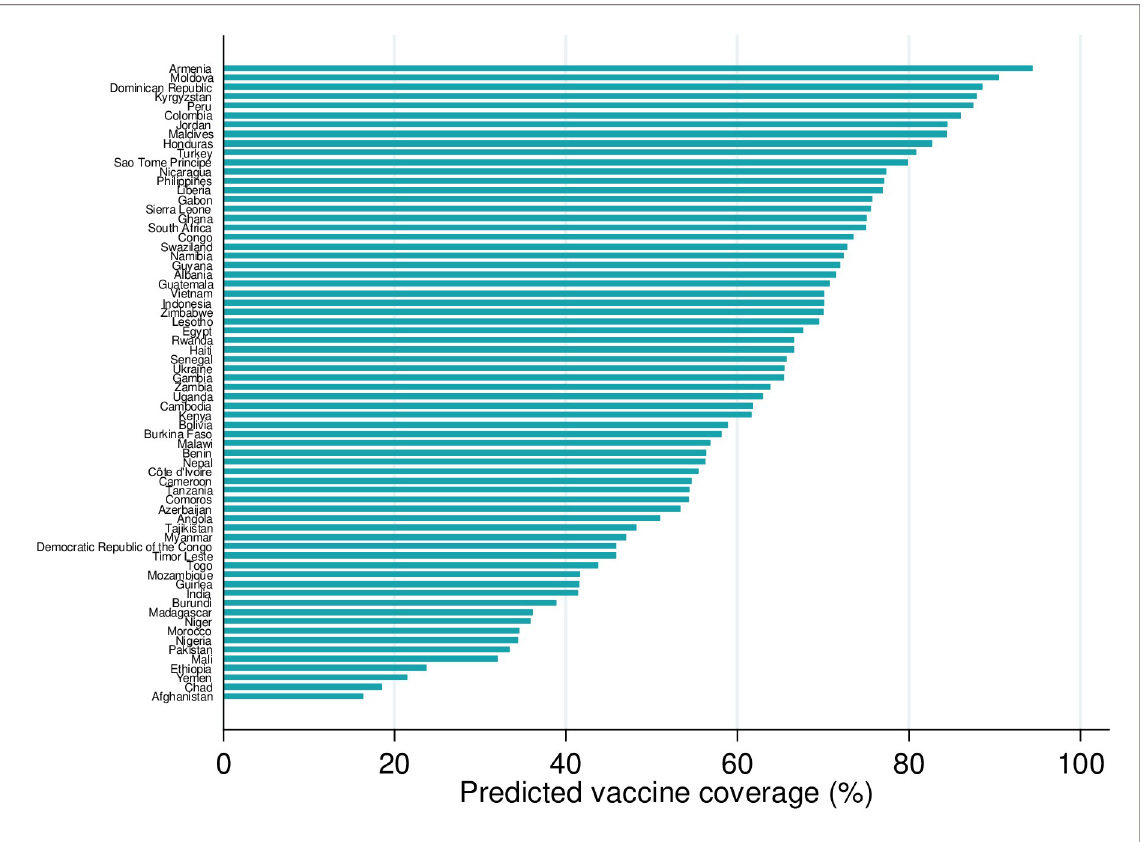
Fig 3. Predicted RSV maternal immunization coverage at 24–36 weeks gestation by country.